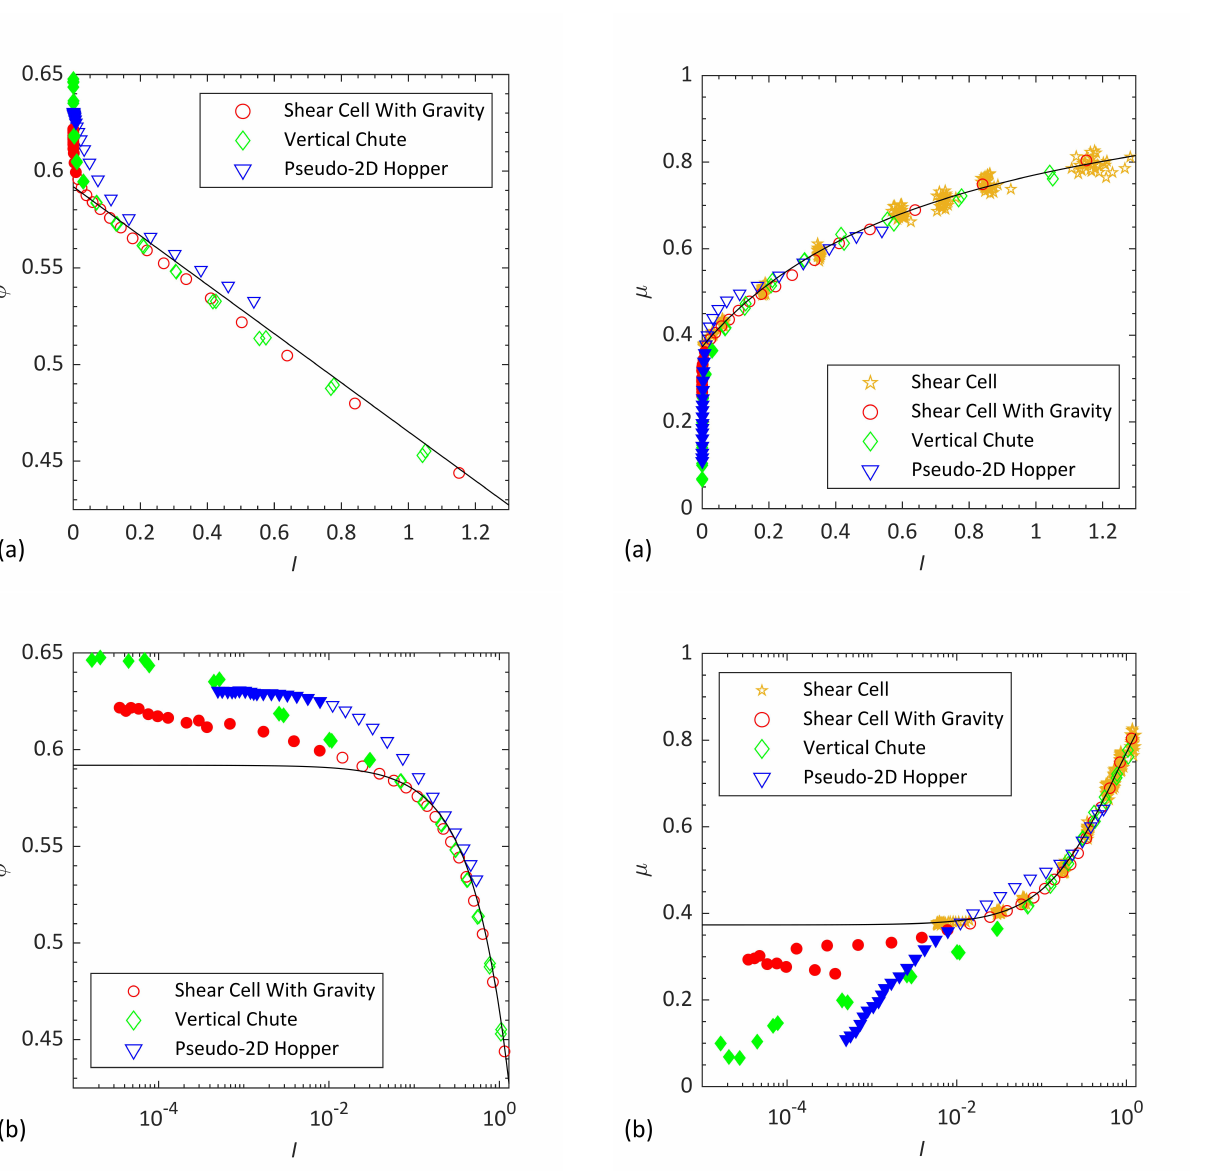
Figure 3. φ vs I plotted for a shear cell with gravity, a verti- cal chute and a pseudo-2D hopper. Filled markers are positions where µ < µ s . Equation 1 is plotted as a line